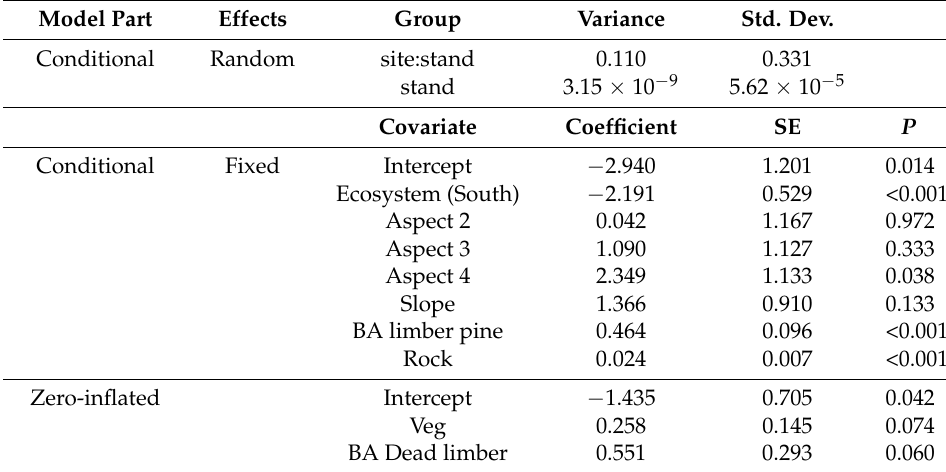
Table 5. Covariates included in the final model from Table